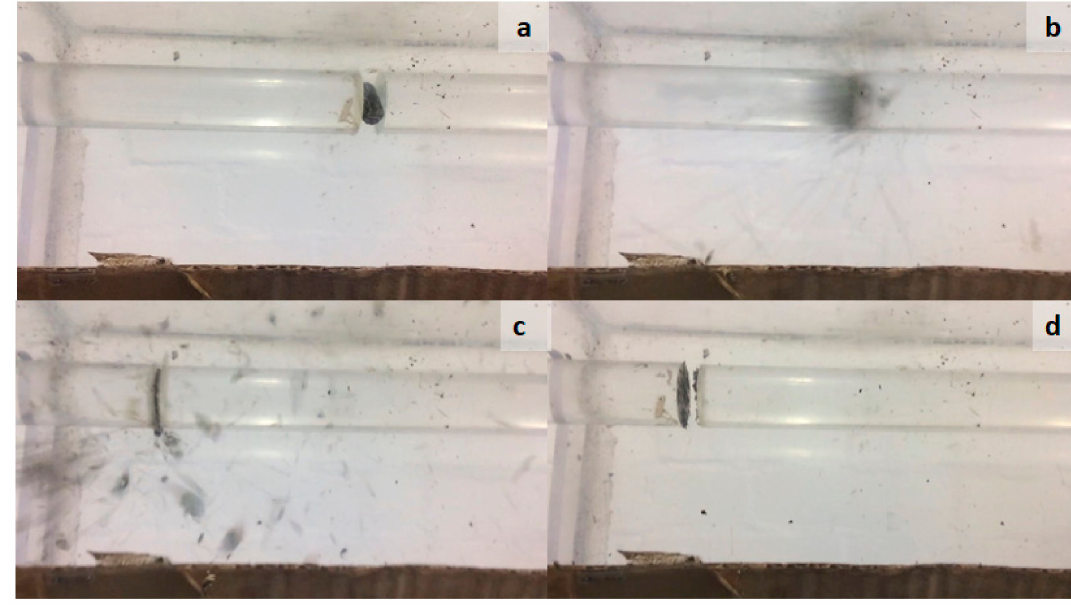
Figure 8. Video stills of SHPB test on mixed wood pellet in diametral orientation. Initial pellet